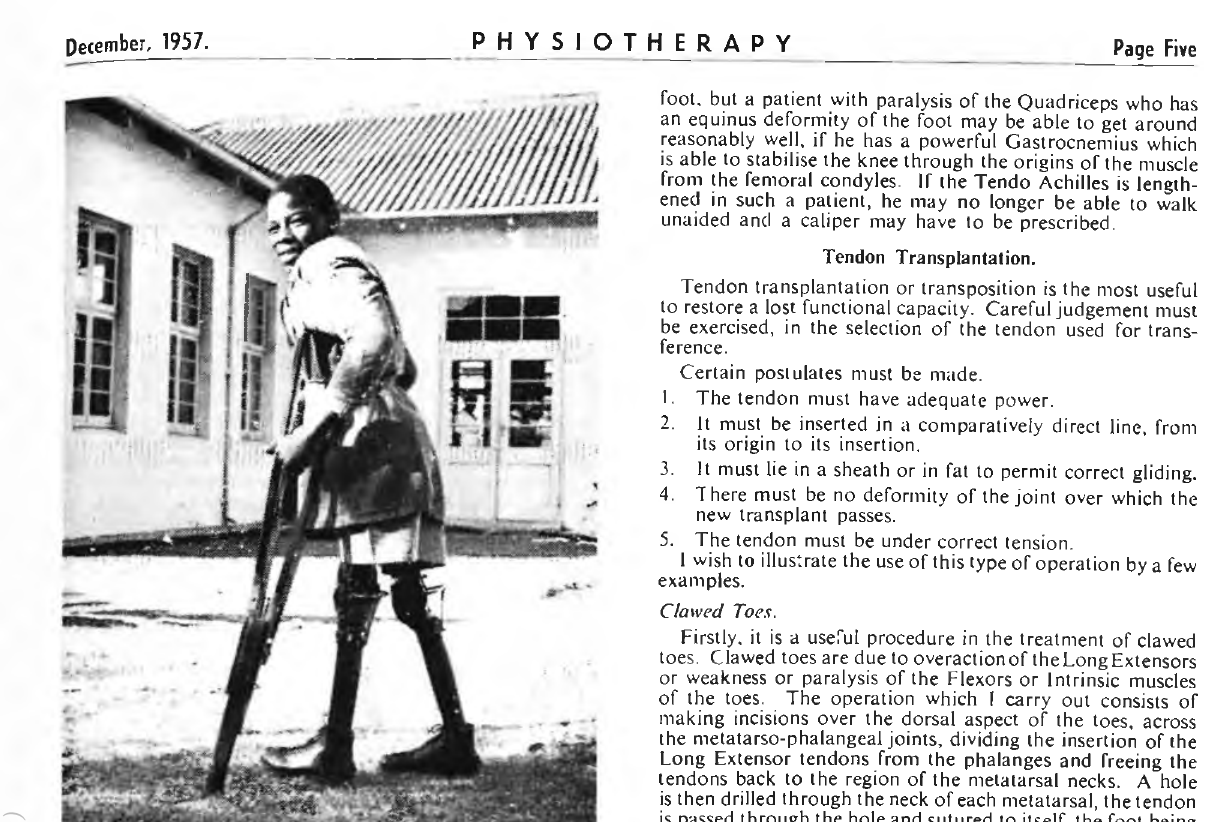
Fig. II Azarial Khokhotho— Polio (after